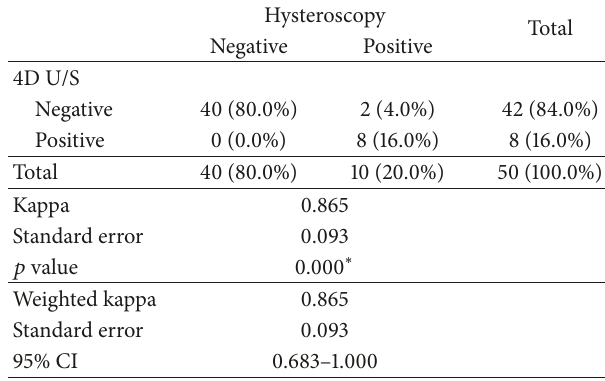
Table 3: Endometrial polyps.